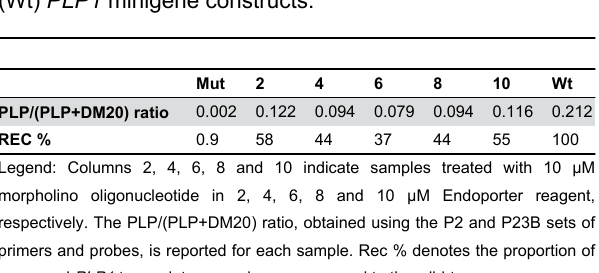
Table 2. Real-time RT-PCR analysis of morpholino-treated Oli-neu cells transfected with mutated (Mut) and wild-type (Wt) PLP1 minigene constructs.